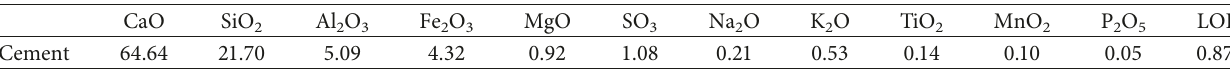
Table 1: Chemical composition of